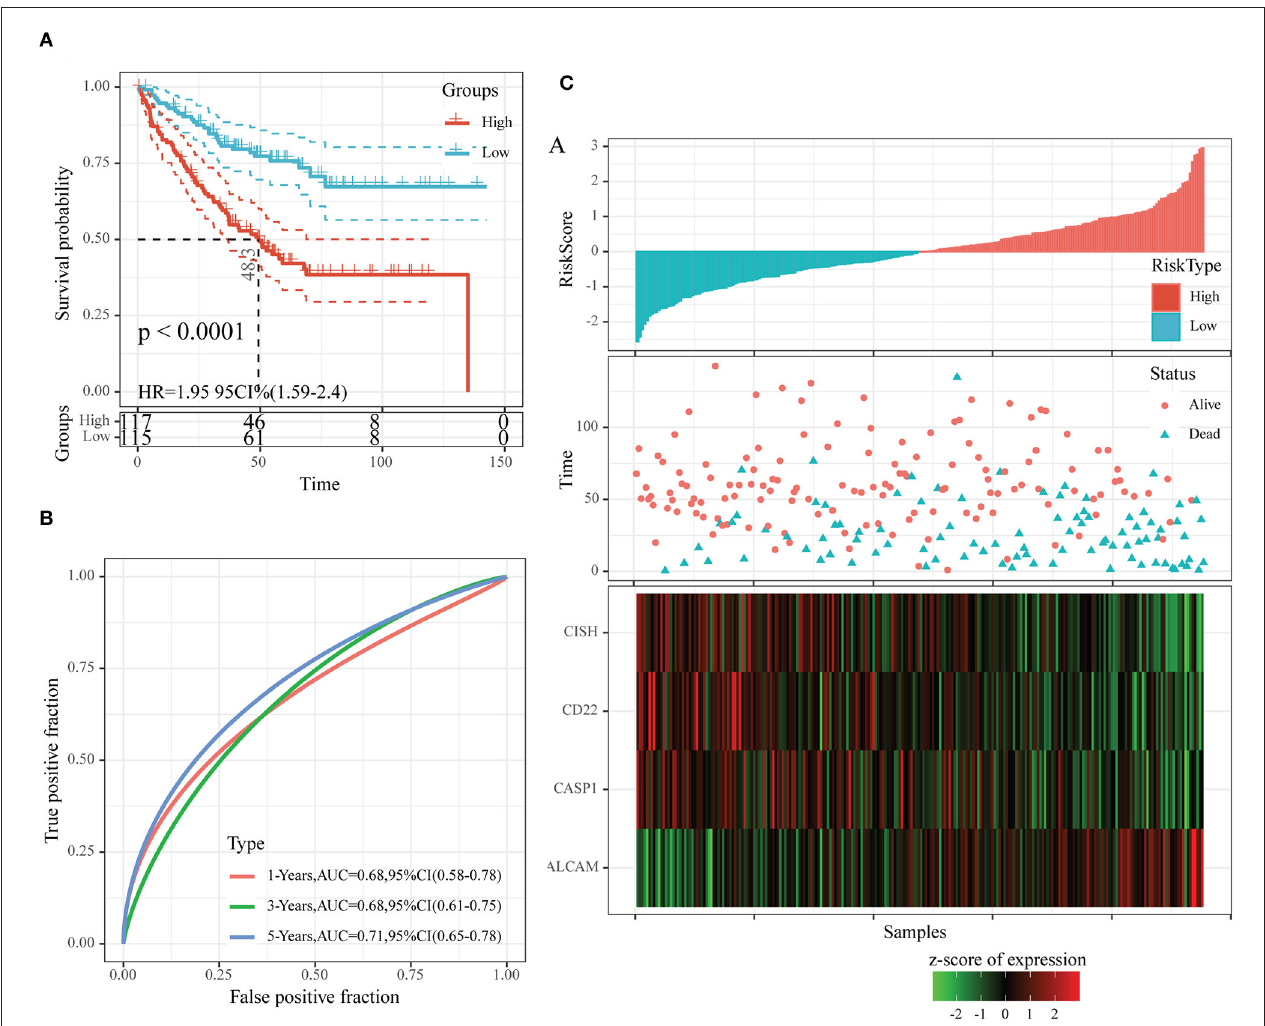
FIGURE 7 | The classification effect of the four-oxaliplatin resistance-related gene-based prognosis signature in the first test set (GSE17538). (A) Analyzed the prognostic difference after predicted classification according to the four-gene signature in the first test set (GSE17538). (B) Receiver operating characteristic (ROC) curves of the four-gene signature in colon cancer samples in the first test set (GSE17538). (C) The relationship of risk score, survival time, and survival status with the expression levels of the four genes in the first test set